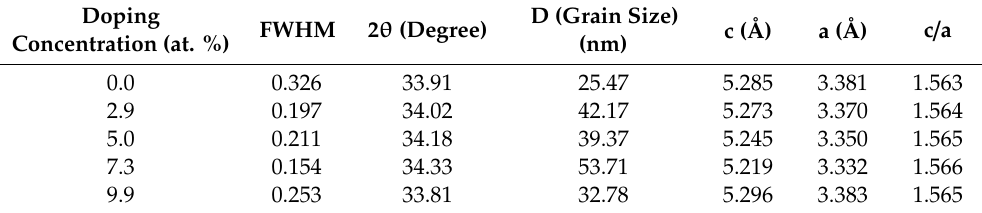
Table 1. Grain size and lattice parameter of Ga-doped ZnO thin films. Doping Concentration (at.